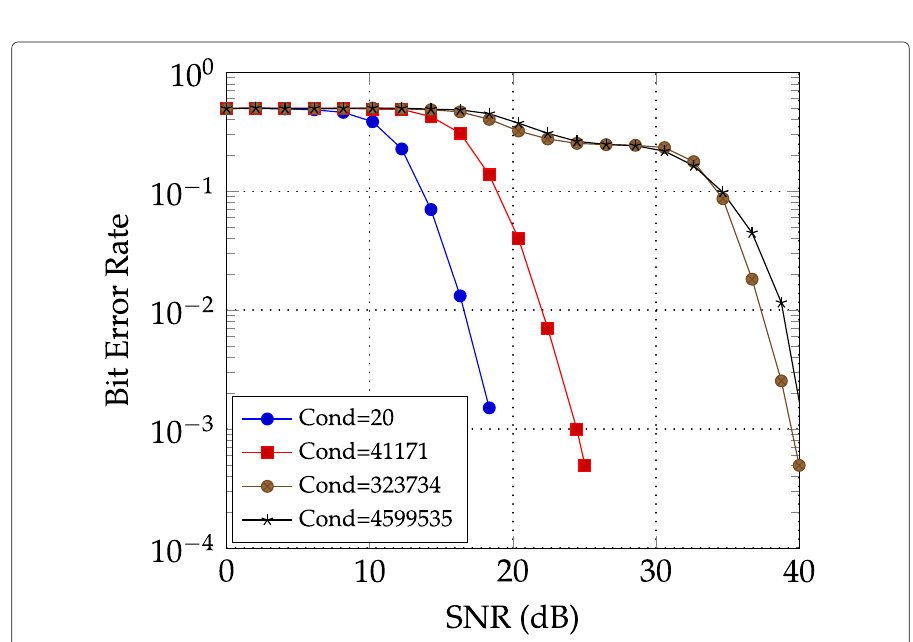
Fig. 2 Effect of the postcoder’s condition number on the BER vs SNR—3 × 3 MIMO